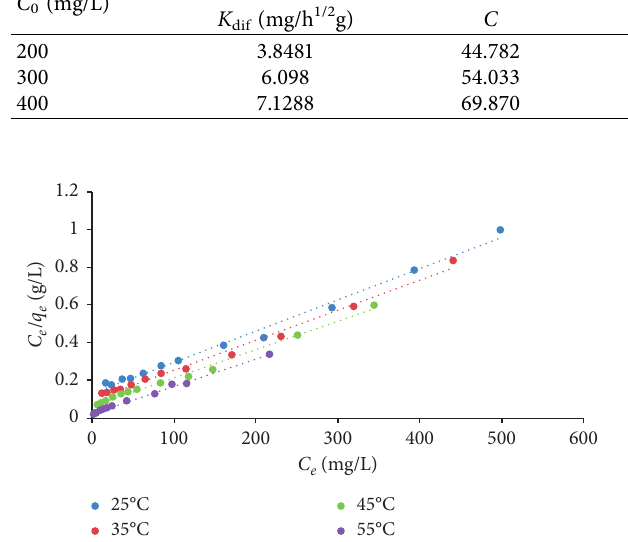
Table 4: Constants of the intraparticle diffusion model for MnO C 0